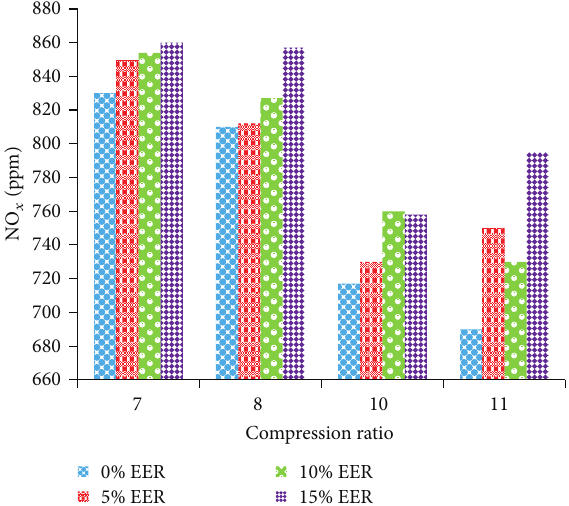
concentration for x